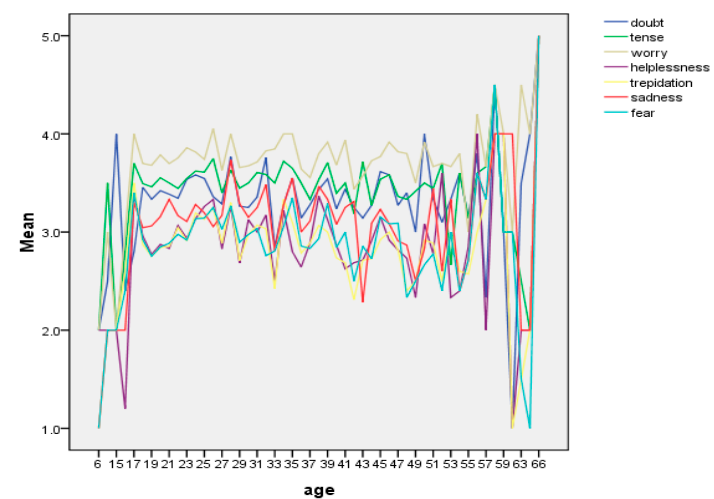
Figure 3. Mean panic rate with age.